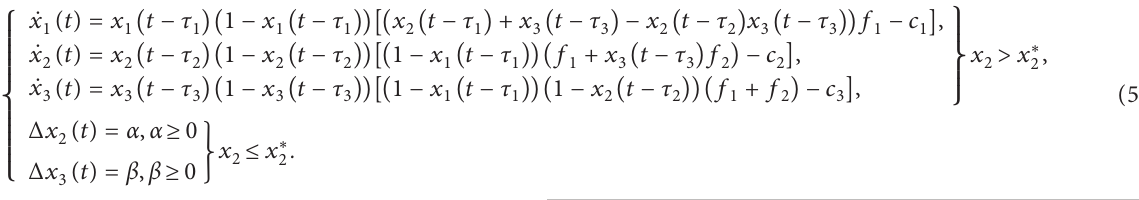
Figure 7: TSGs of x and (d) x ∗